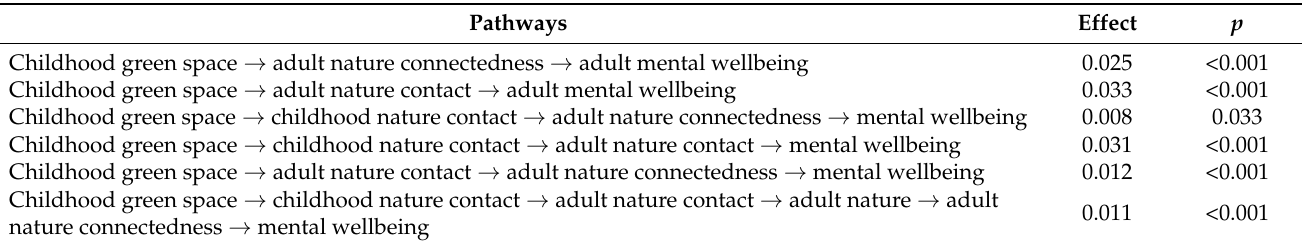
Table 4. Indirect pathways between childhood residential green space and adult mental wellbeing.